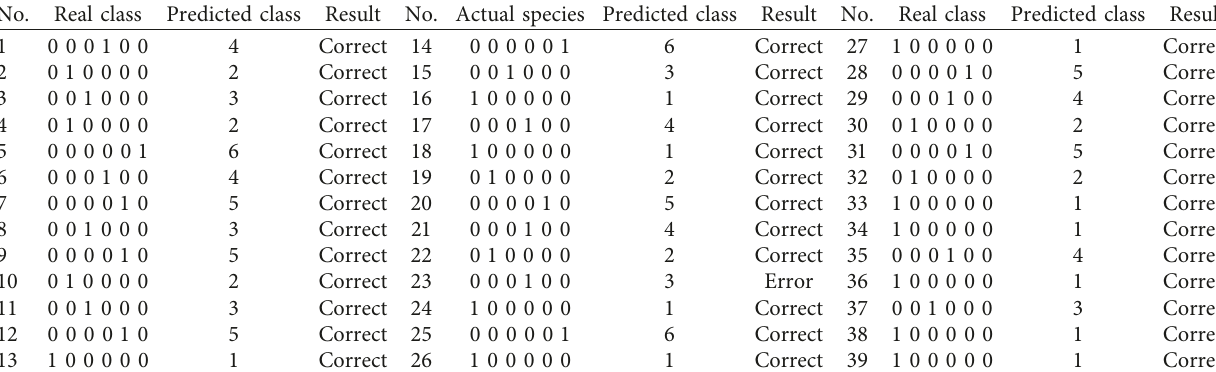
Table 4: Predicting results of BPNN model in the validation set.